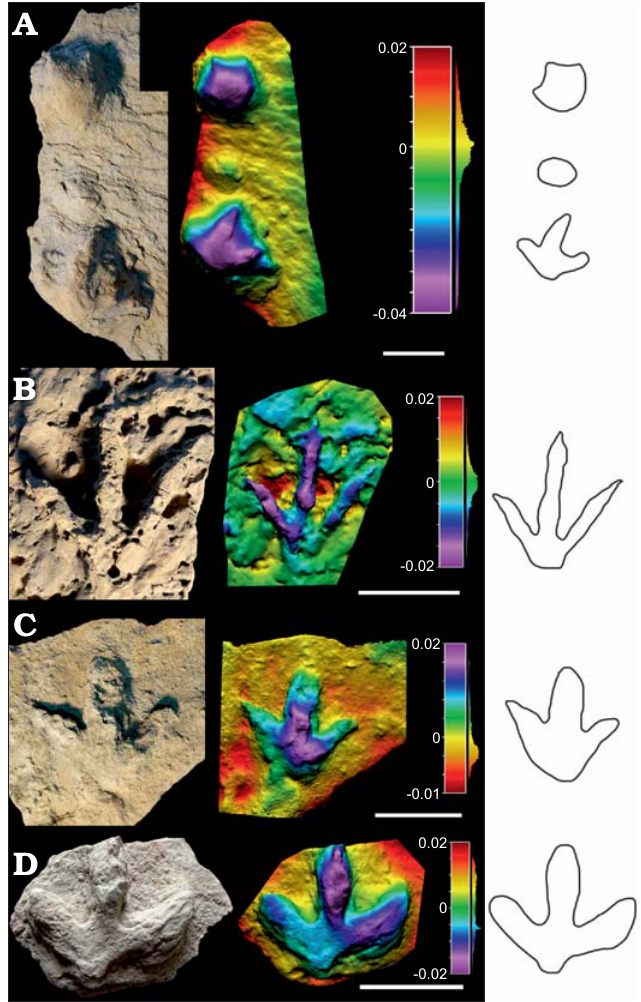
Fig. 4. Photographs, false-colour depth maps and outline drawing of the tracks of high morphological quality (MP = 2) that belong to the Ano- moepus ? isp. morphotype, Portugal, Alcobaça Formation, Kimmeridgian– lower Tithonian (A, B), Praia de Amoreira-Porto Novo Formation, upper Kimmeridgian (C), and Freixial Formation, middle–upper Tithonian (D). A . SHN.(JJS).ICNO.29, Serra do Bouro. Note the possible manus track. B . SHN.(JJS).ICNO.56, Boavista do Bouro. C . SHN.(JJS).ICNO.103, Santa Rita, Foz Velha. D . SHN.(JJS).ICNO.74, Cambelas Sul. Scale bars 10 cm.